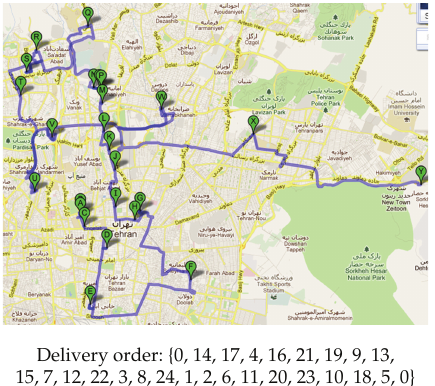
Figure 3: The best found delivery order when hiring one vehicle. Note that from location Y, the vehicle must return to its origin, A.